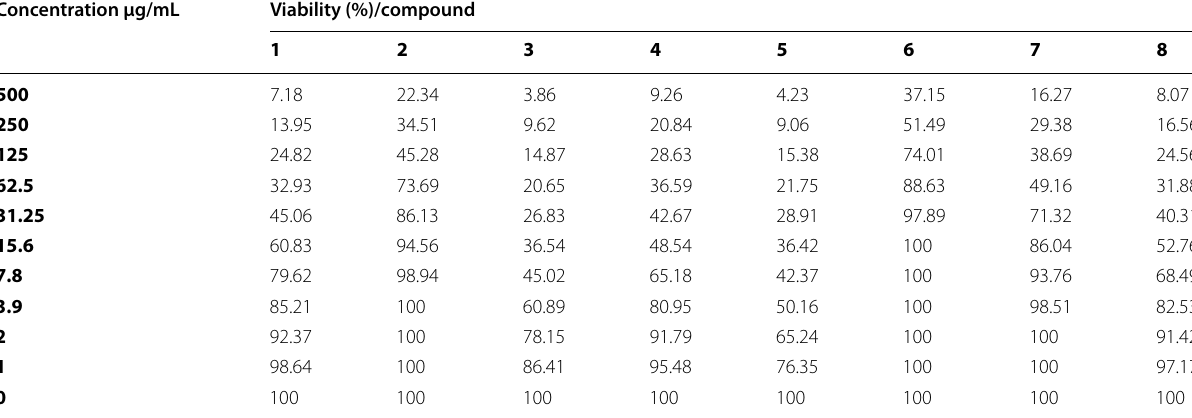
Table 4 Cytotoxicity of compounds 1, 2, 3, 4, 5, 6, 7 and 8 against breast carcinoma cell line MCF-7 Concentration